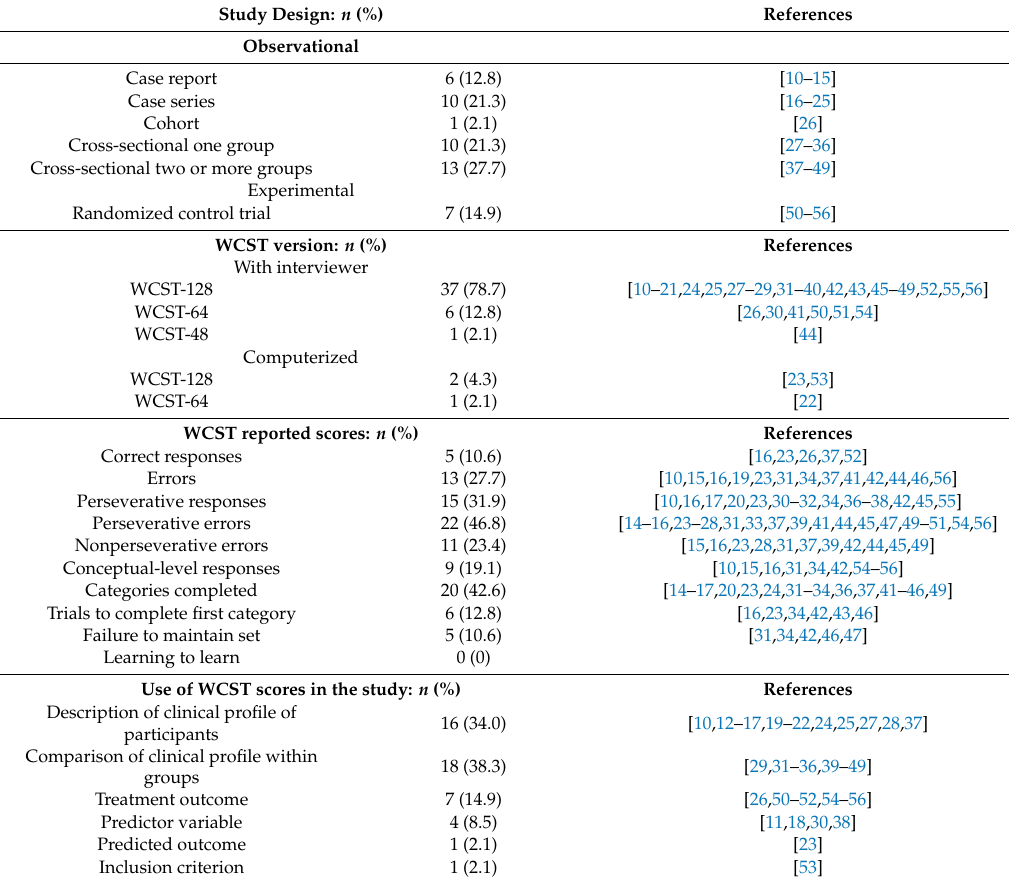
Table 2. Study design features of publications ( n =